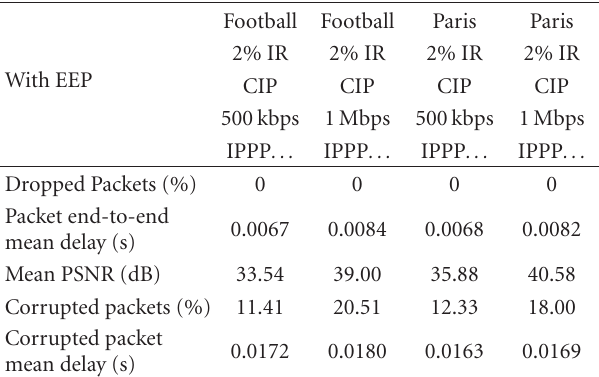
Table 7: Metrics for channel 2 with UEP.